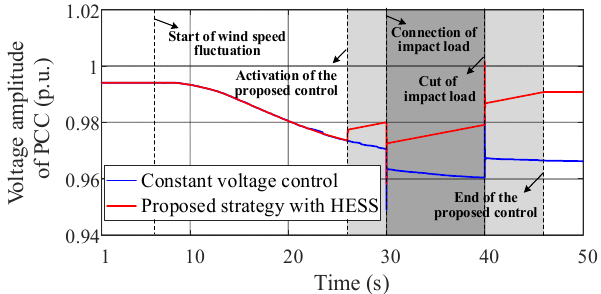
Figure 12. The voltage amplitude of PCC in case I. In the scene of wind speed change, the reactive power decreased from 0.378 p.u. to 0.125 p.u., when the constant voltage control is only adopted by the DFIG, as shown via the blue line in Figure 13. Although more reactive power is output by DFIG after the impact load is connected, this cannot stabilize the voltage fluctuation of PCC. In the actual system, the rotor speed which is proportional to the wind speed changes slowly. At around 50 s, the rotor speed of the wind turbine increases to the critical speed under the variation of the wind speed shown via the blue line in Figure 14. The pitch angle remains at 0 ◦ , emerged via the blue line in Figure 15.